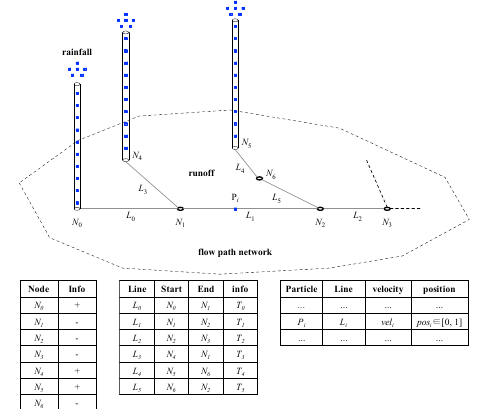
Figure 3: The parallel framework for high-performance simulating rainfall-runoff dynamics based on particle